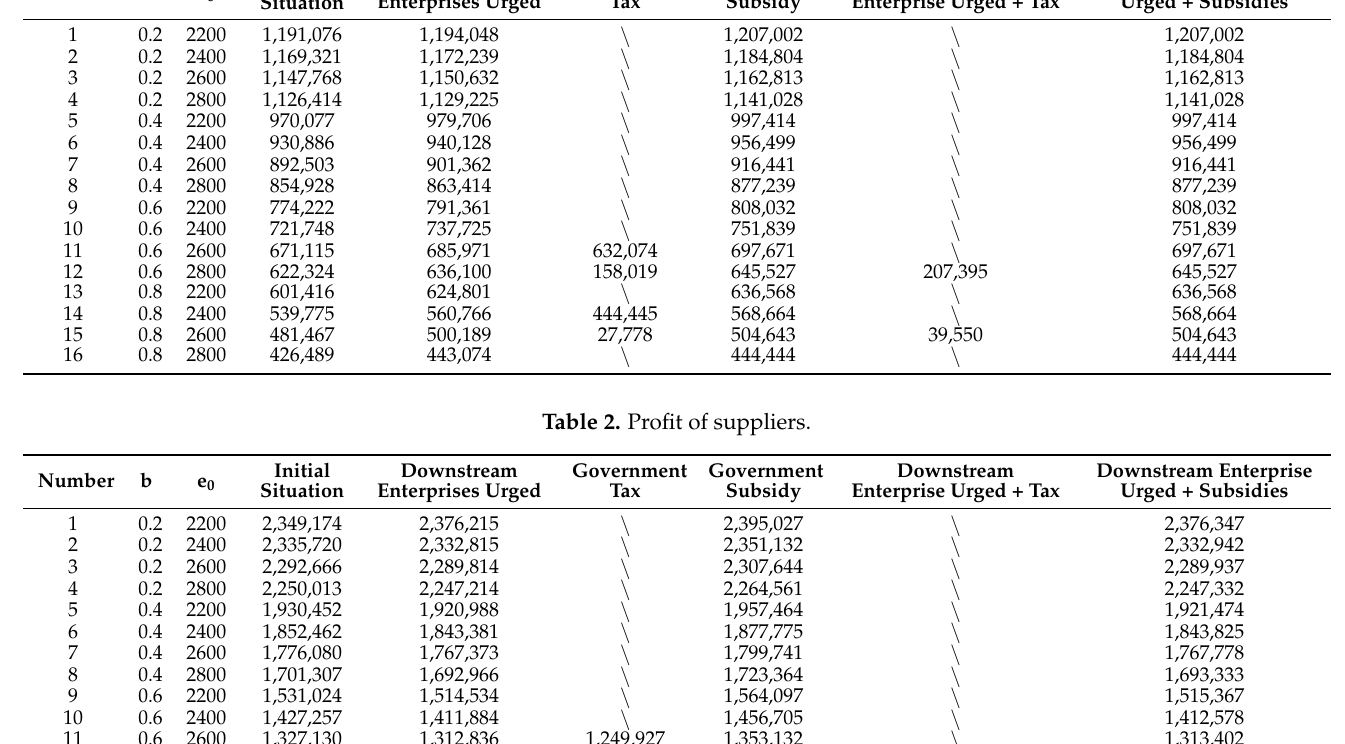
Table 1. Profit of downstream enterprises.